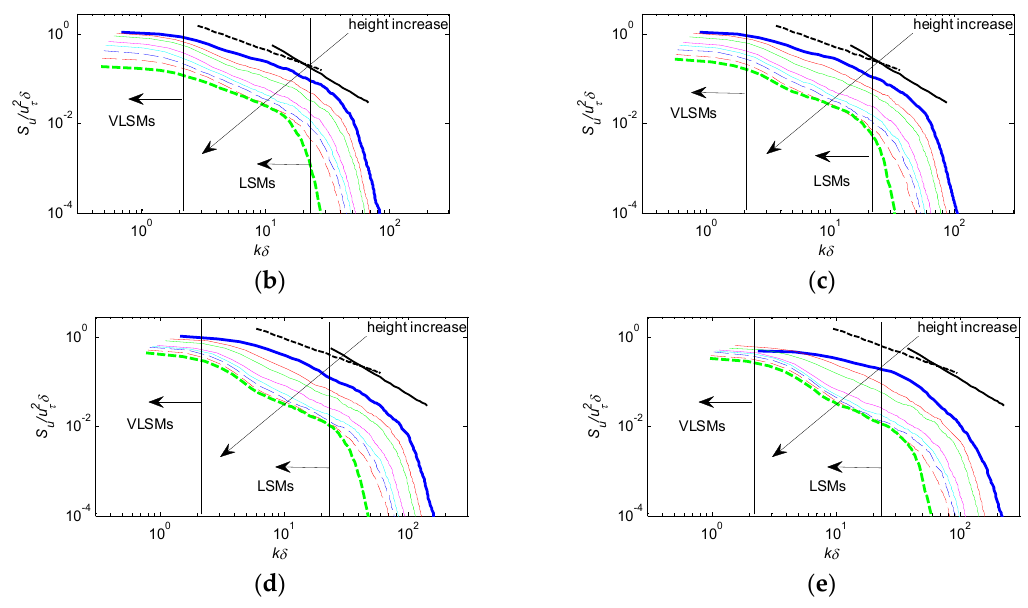
Figure 9. Power spectra of streamwise velocity fluctuations. ( a ) case 1, ( b ) case 2, ( c ) case 3, ( d ) case 4 and ( e ) case 5. The height indicators for each graph are the same as those shown in ( a ), that is, 7.5 m, 27.5 m, 47.5 m, 67.5 m, 87.5 m, 107.5 m, 127.5 m, and 147.5 m. Further, the boundary layer height is 250 m, 300 m, 350 m, 450 m, and 550 m for cases 1, 2, 3, 4, and 5, respectively.